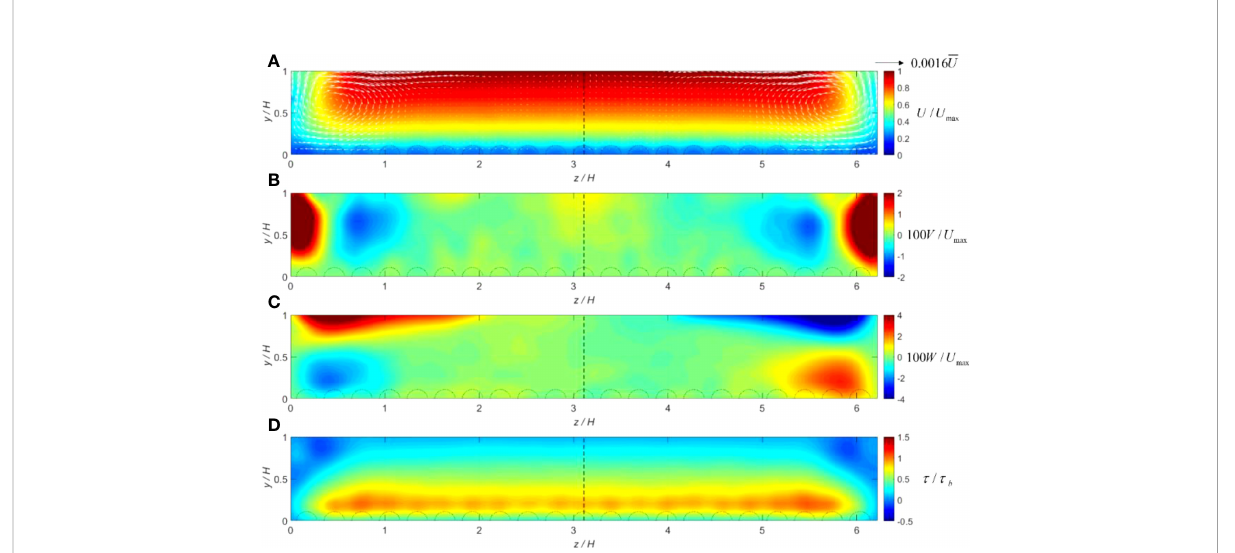
FIGURE 9 (A – D) Cross-sectional distributions of hydrodynamic parameters computed for fl ow condition 3 (deep depth: Re = 25,200) including the roughness elements: normalized mean (A) streamwise velocity with vector fi eld; (B) vertical velocity; (C) lateral velocity; and (D) shear stress. The dashed semicircles at the bottom of each panel represent the rough bed spheres.